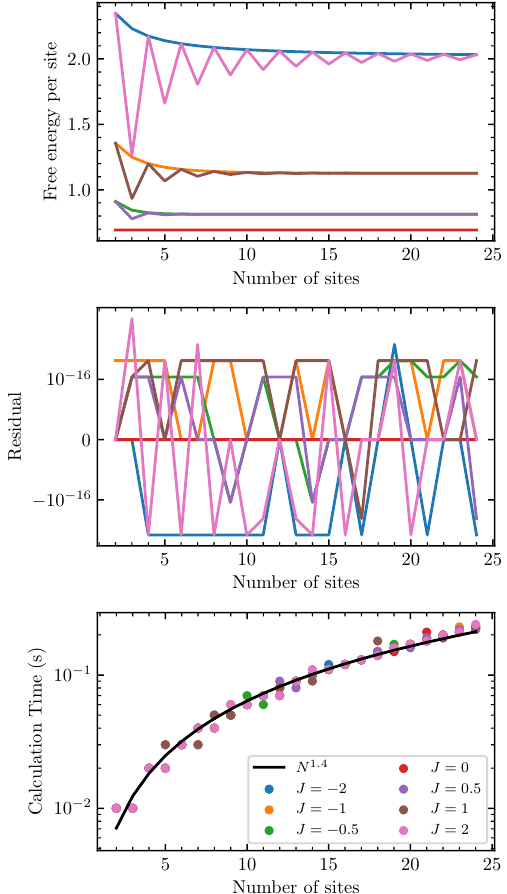
Figure 20: The free energy per site from PyTNR (top), residuals (middle) and run time (bottom) for the 1D Ising model with nearest neighbor interactions is shown as a function of the number of sites for a variety of interaction strengths J . Note that models with J > 0, which prefer antiferromagnetic ordering, exhibit a dependence on the parity of the number of